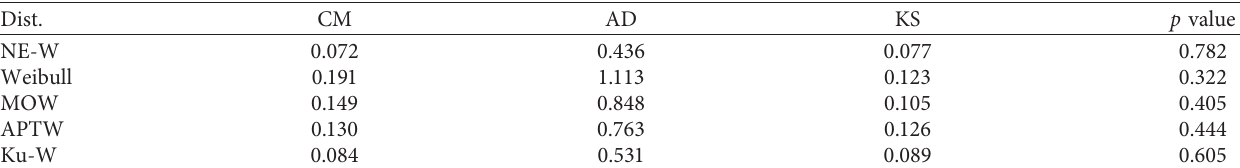
Table 5: Goodness of fit measures of the fitted models for data 1. Dist.